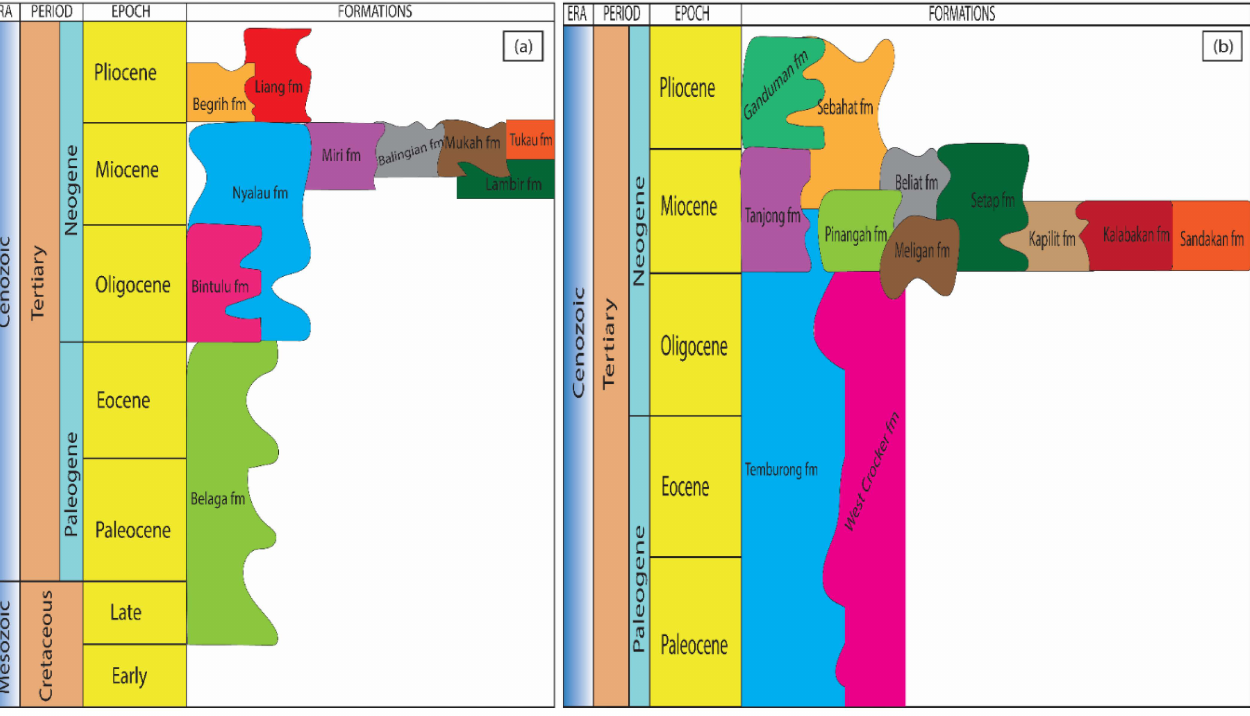
Figure 3. ( a ) A stratigraphic map showing the formations studied in Sarawak ( b ) A stratigraphic map showing the formations studied in